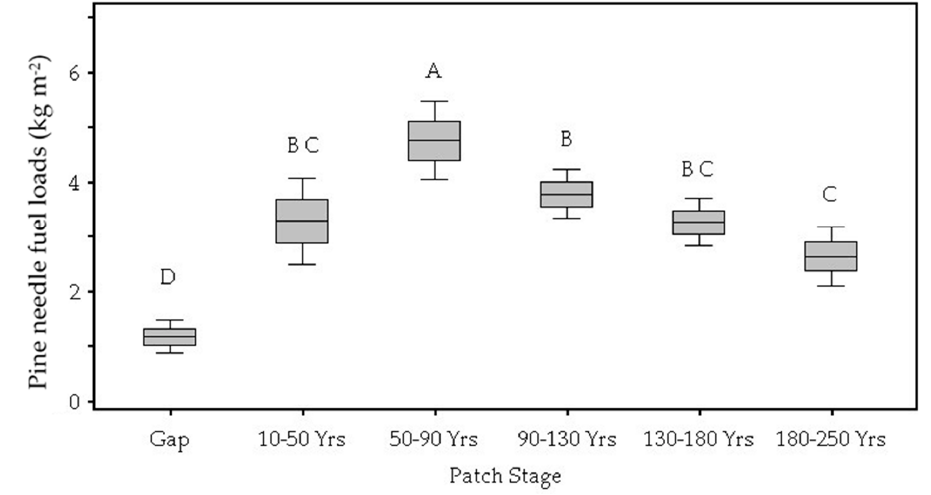
Figure 4. Pine needle fuel loads in patch stages. Pinus palustris needle litter accumulation (kg m − 2 ) in plots in each patch stage ( n = 10). Boxes represent plot distribution within one standard deviation of the mean (box centerline). Error bars indicate standard error and shared letters indicate non-significant differences among patch stages .